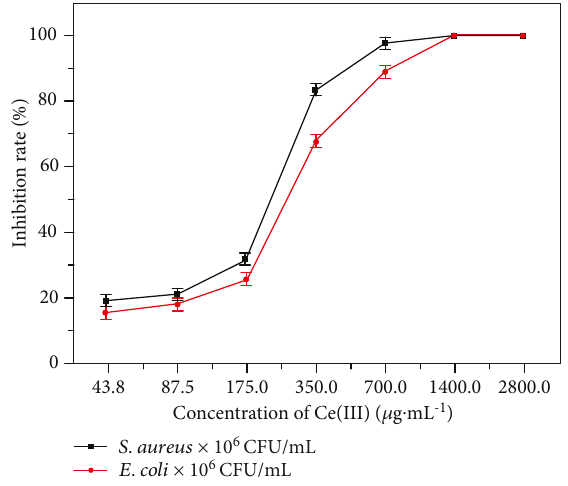
Figure 8: Inhibition rate of CGCe against S. aureus and E. coli .